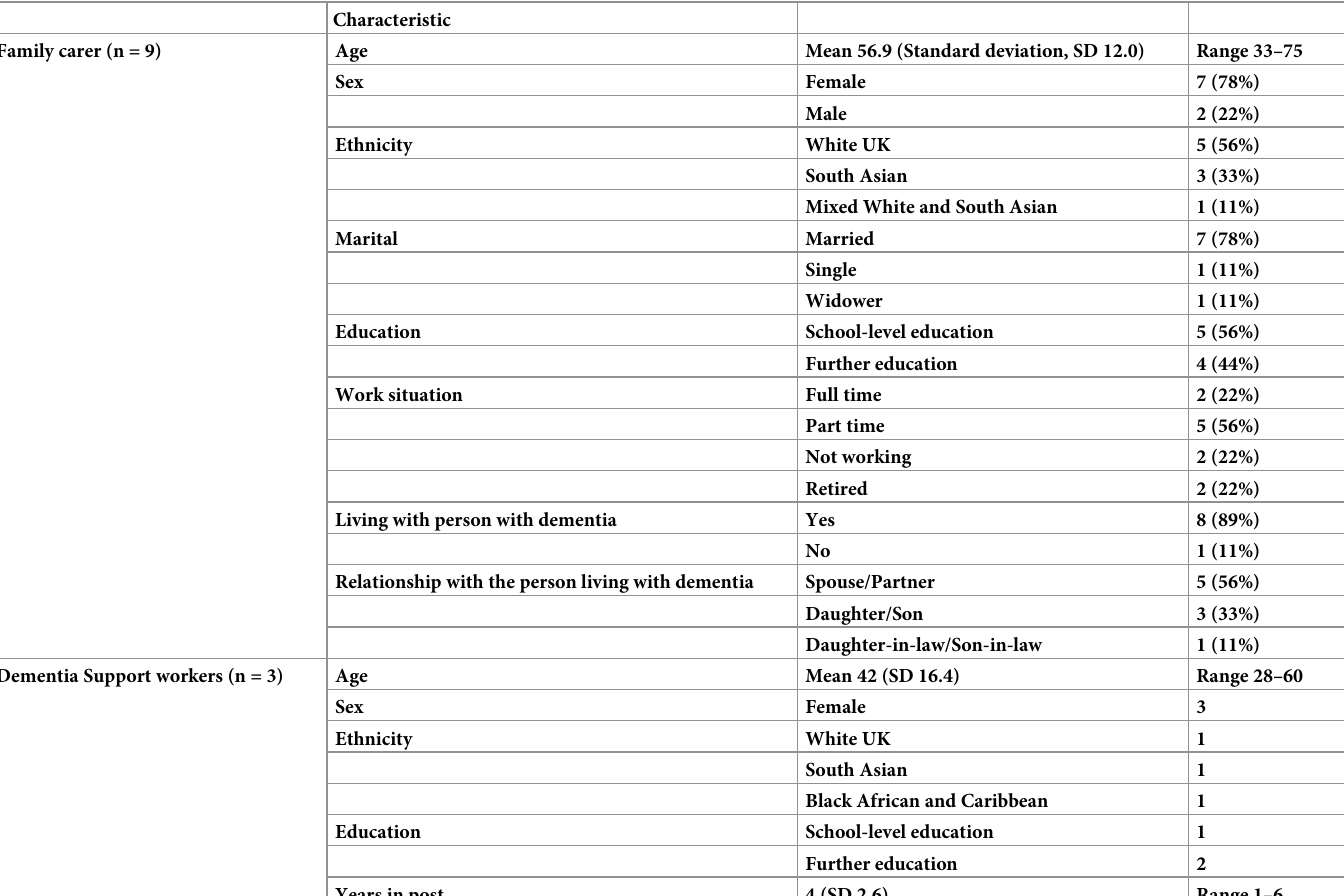
Table 2. Family carer and dementia support worker